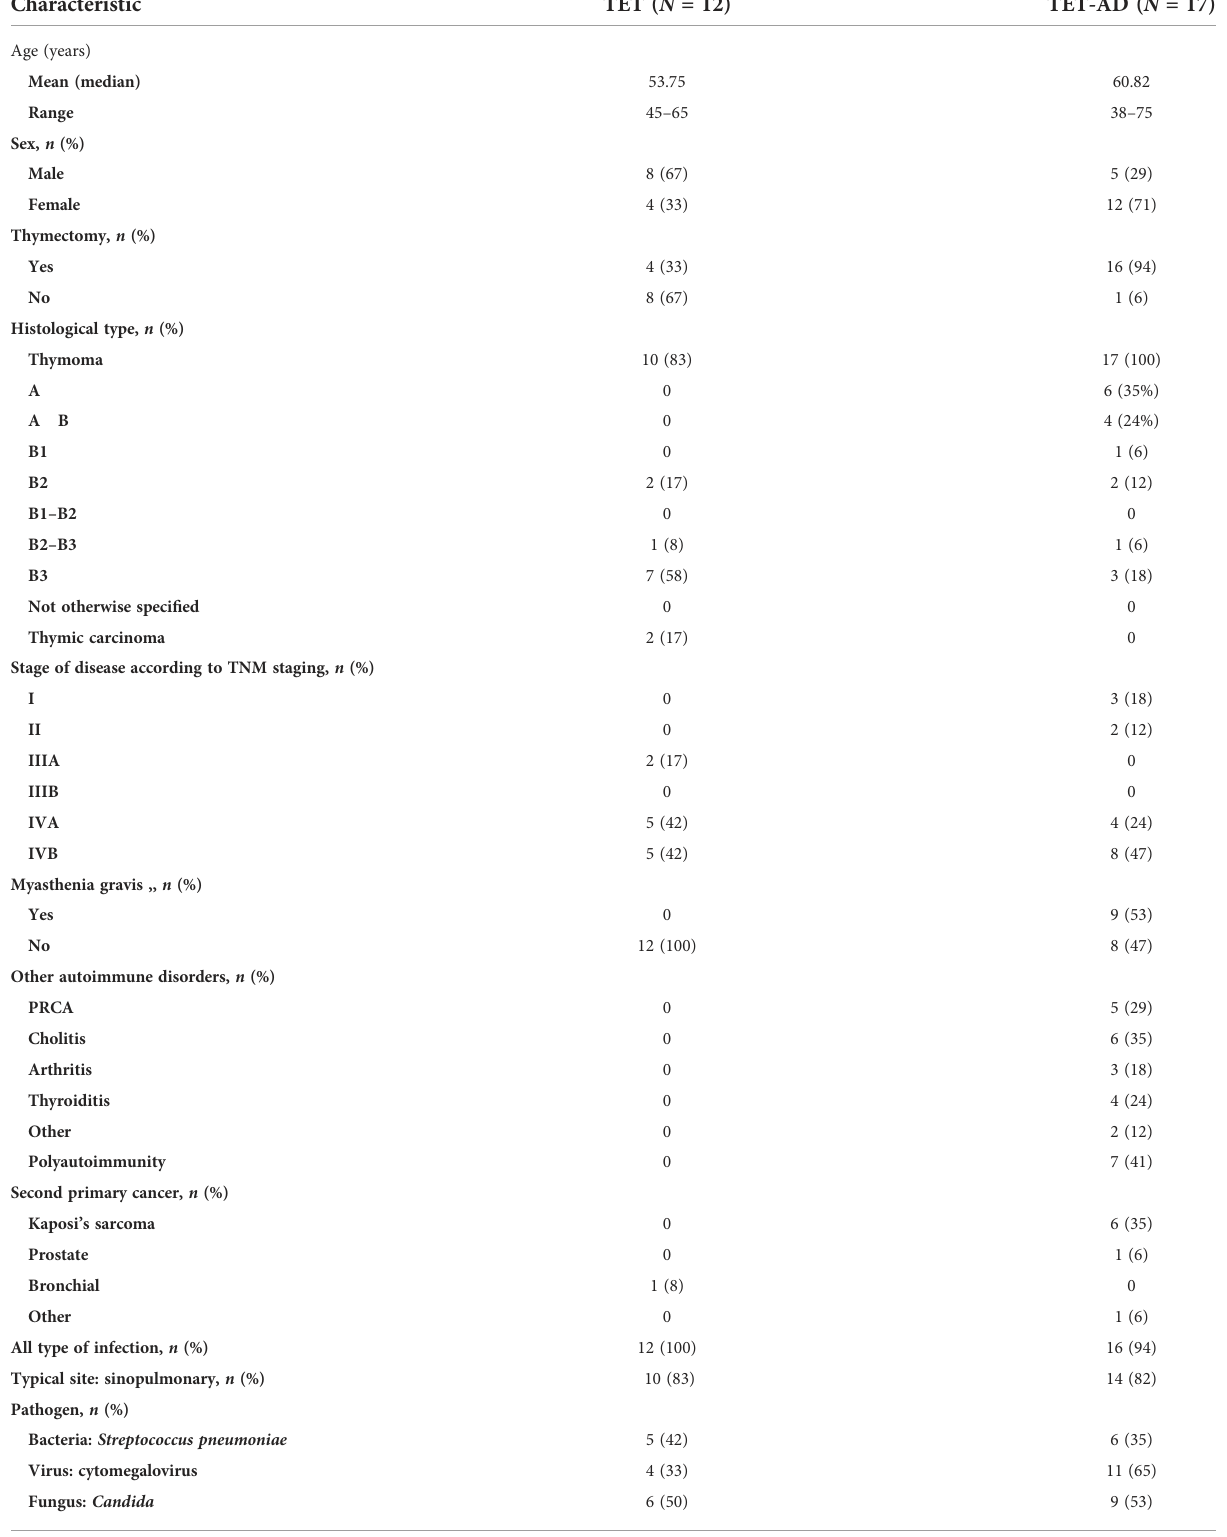
TABLE 2 Clinical features of TET-GS patients with or without AD (n 29).